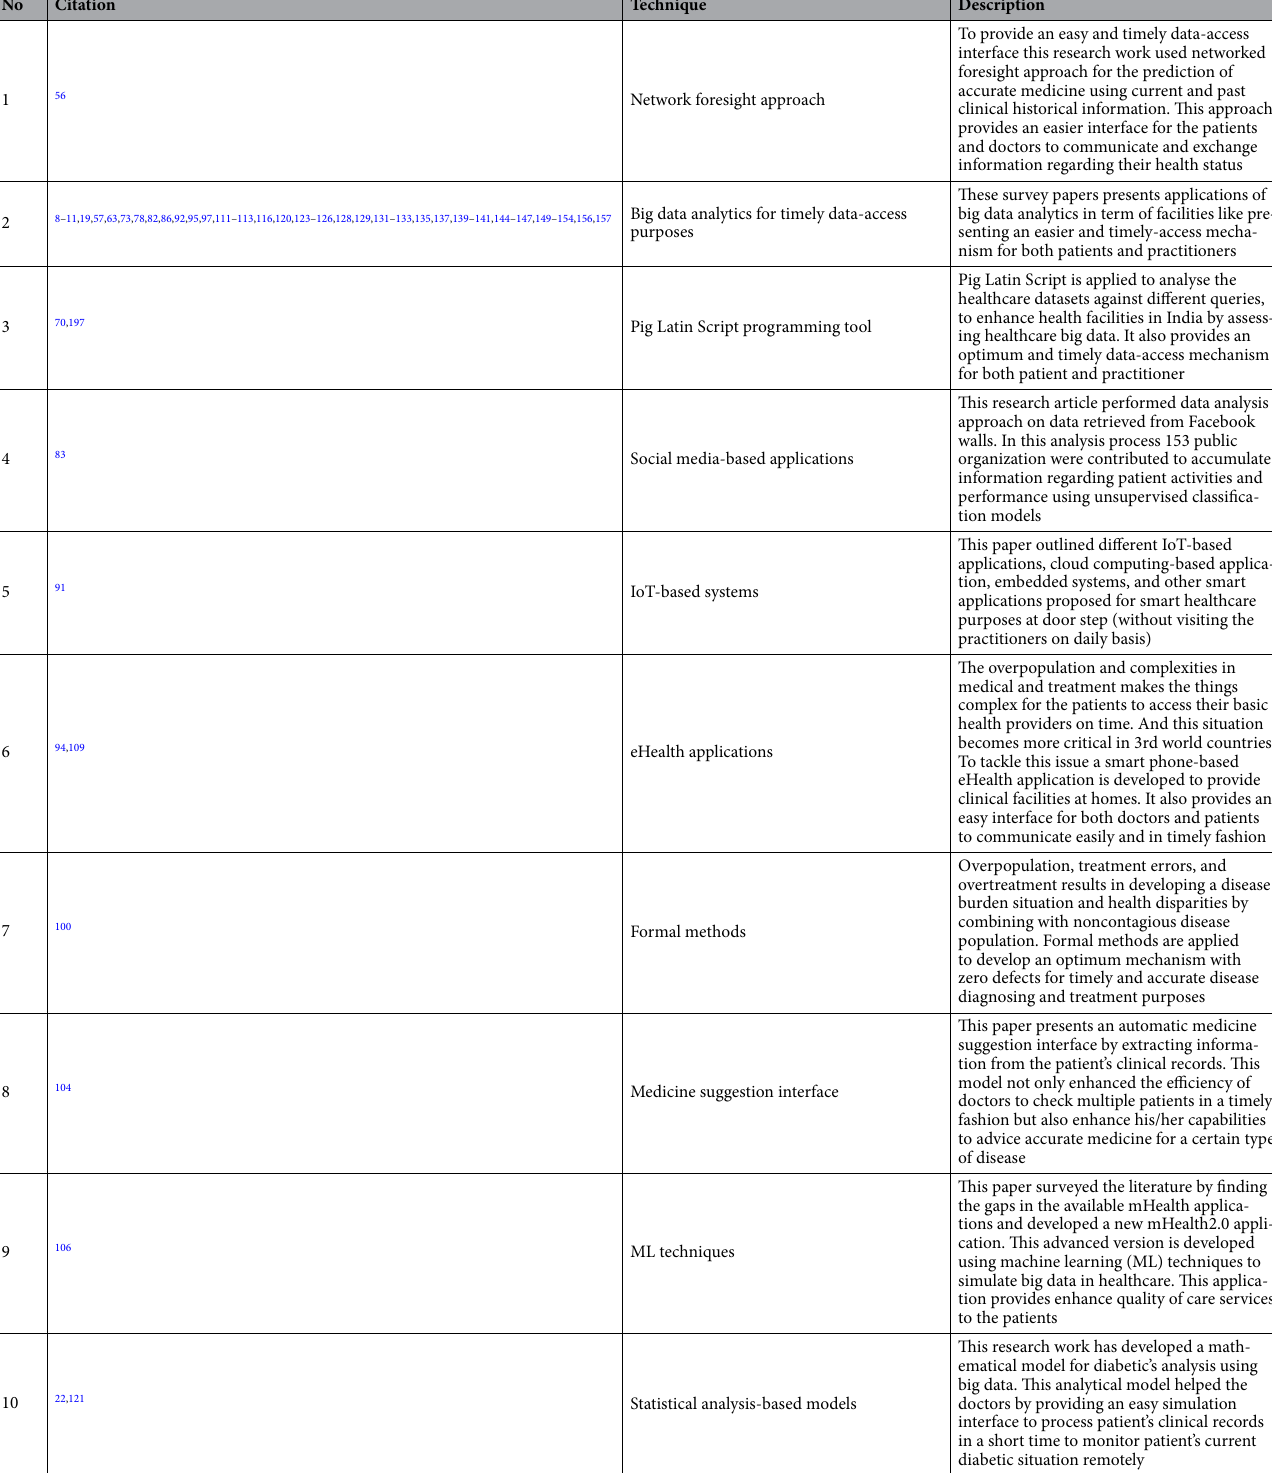
Table 8. List of techniques proposed for easy and time data-access